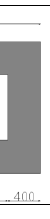
Figure 5. Reference courtyard form and dimensions (m). Table 7. Different settlement layouts with streets with widths of 3 and 6 m.